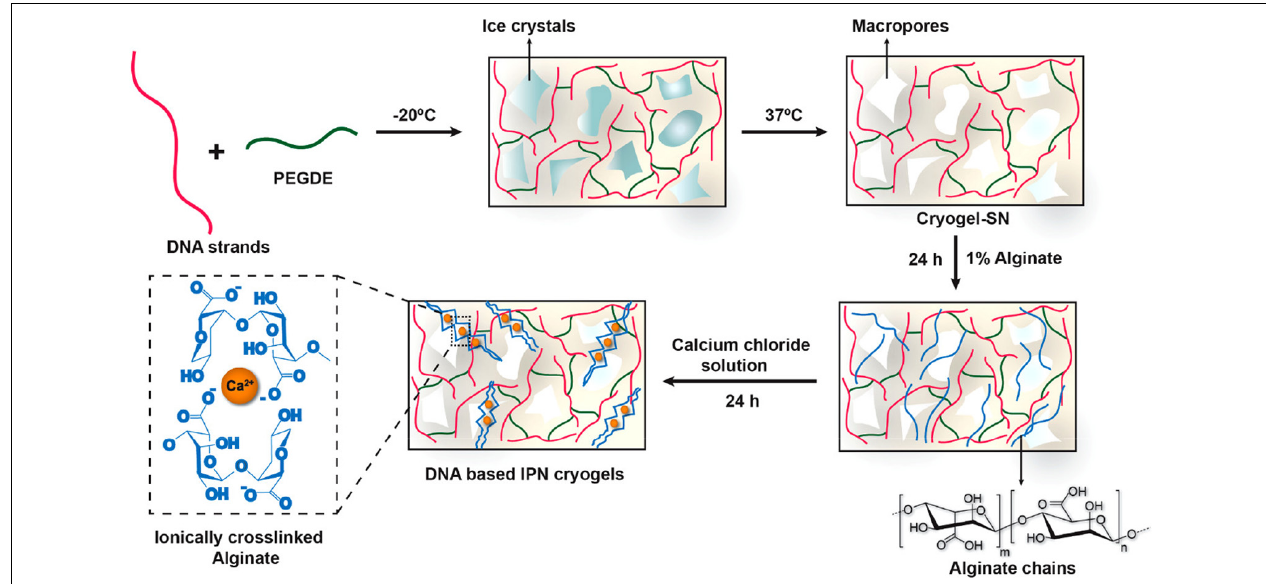
FIGURE 4 | Sequential strategy for the development of DNA-based interpenetrating network cryogels from DNA and alginate. Reprinted with permission from Basu et al. (2020). Copyright (2020) American Chemical Society.